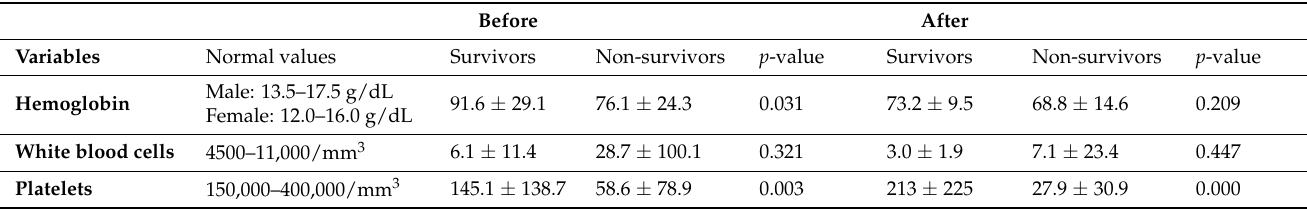
Table 2. Laboratory data